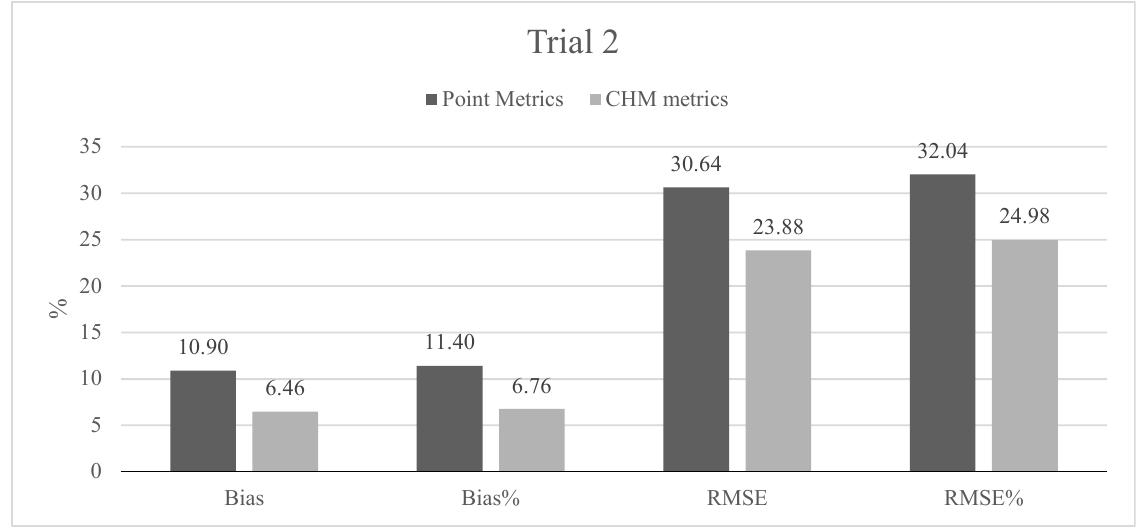
Figure 2. The effect of the derived metrics on the prediction accuracy of totalB. ( Trial 1 ) Training set = Optech-plots; Test set = Leica-plots; and ( Trial 2 ) Training set = Leica-plots; Test set =